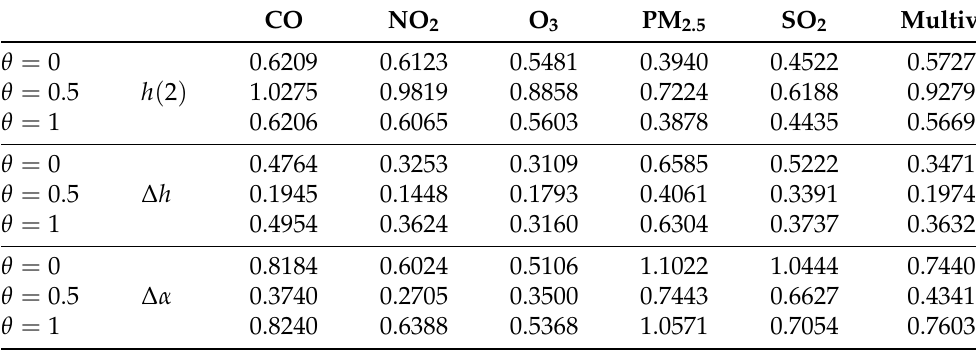
Table 6. The scaling exponent h ( 2 ) , multifractality degrees ∆ h , and ∆ α : remainder